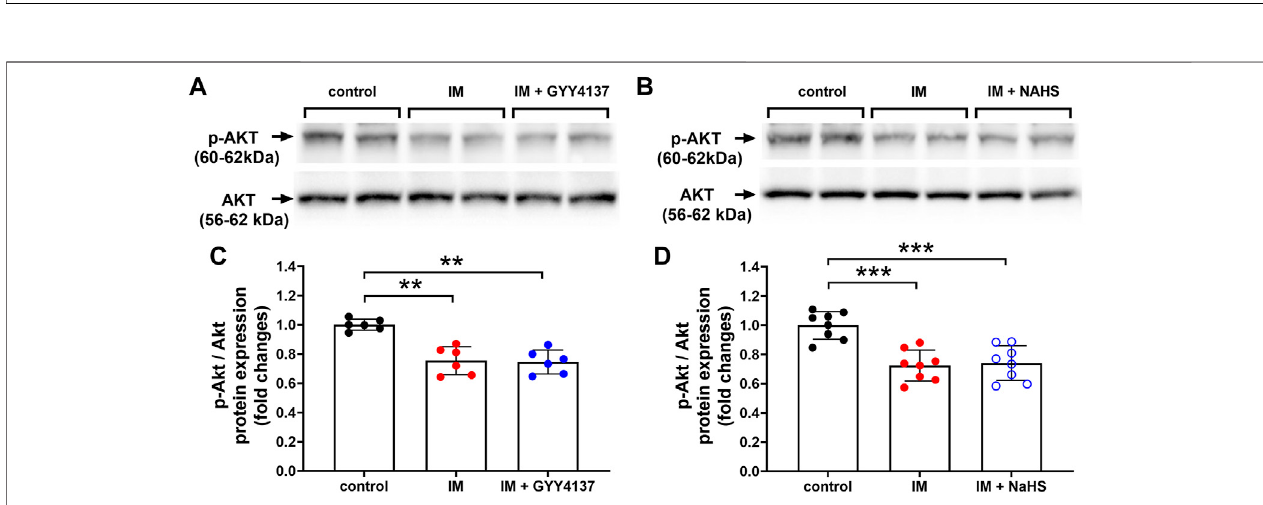
FIGURE 11 | H2S donors have no effect on p-AKT/AKT protein expression in skeletal muscle. Mice were subjected to IM and treated with GYY4137 (a and c, 50 μ g/kg/d, ip), or NaHS (b and d, 1.12 mg/kg, twice a day, ip) for 2 weeks. The control and IM groups received identical doses of saline for 2 weeks. (A) & (C) , p-AKT/ AKT protein expression by Western blotanalysisof TAmuscle in control, IM, and IM + GYY4137 mice (n =6 in each group). (B) & (D) , p-AKT/AKT protein expression by Western blot analysis of TA muscle in control, IM, and IM + NaHS mice (n = 8 in each group). Data represent means ± SEM. * p < 0.05, ** p < 0.01, *** p < 0.001.